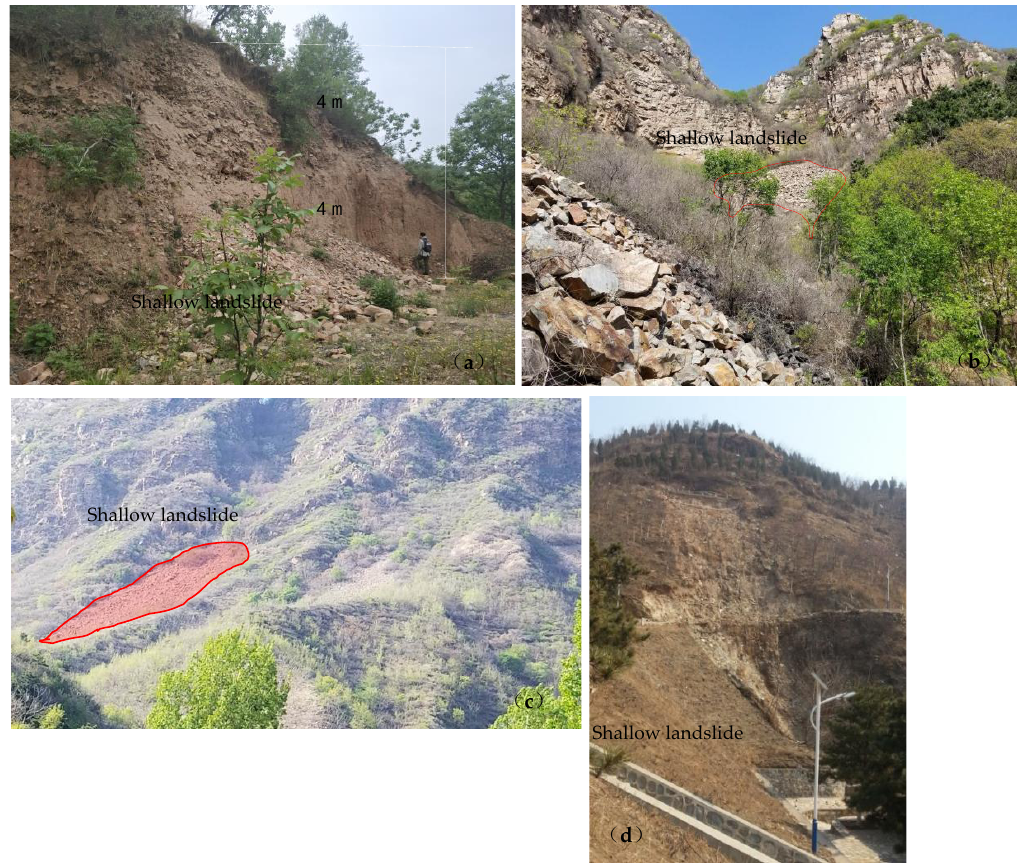
Figure 3. Field investigation photos. ( a ) Shallow landslide in Hetaowa village; ( b ) shallow landslide in Guanshang village; ( c ) shallow landslide in Taoyuan village; ( d ) shallow landslide in Qingshui village.